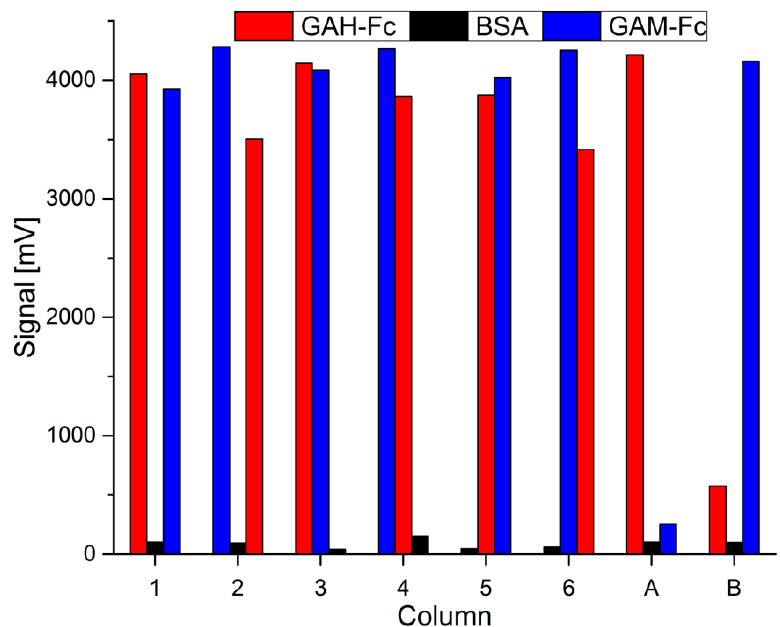
Figure 7. Graphical representation of the measurement signals. Standard deviations are too small to be depicted. All six possible combinations of three different filters were prepared as individual columns and used in an assay. They are marked here as 1–6. The measurements where only rAb M12 or mAb 54k was used as single analyte are marked as A or B, respectively. The order of the filters inside one measurement run is expressed in the order of the columns from left=top to right=bottom, while the immobilized capture antibody is shown by the color of the column.